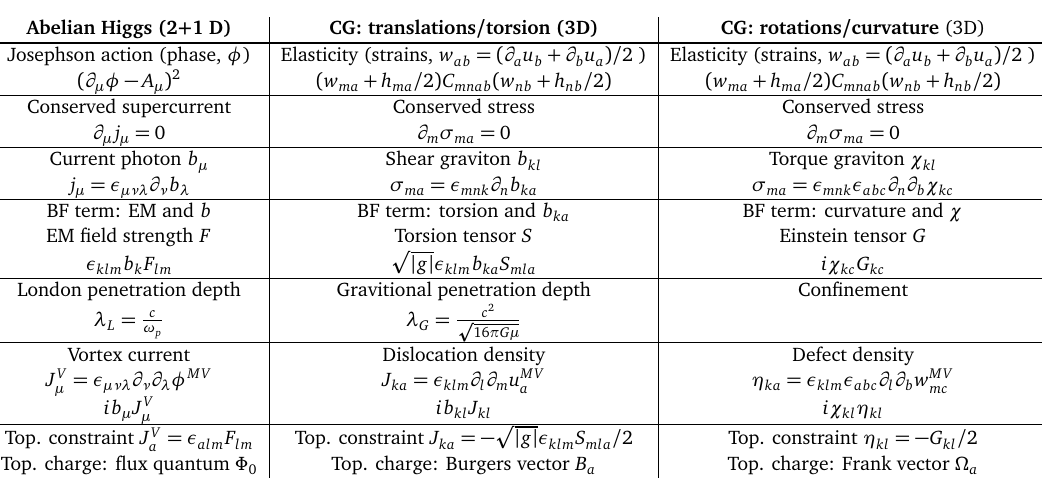
Table 1: The route map of the duality